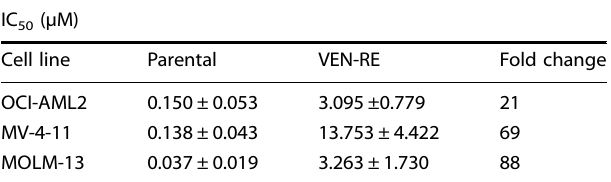
Table 1. VEN IC 50 in parental and VEN-RE cells IC 50